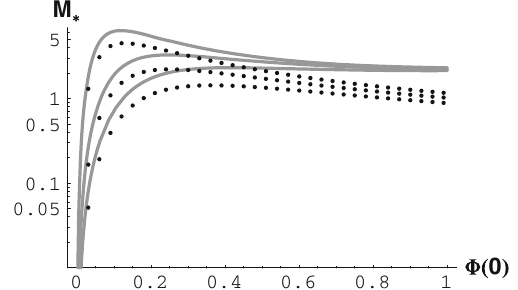
Fig. 7 Charged boson star mass (approximated using the second-order √ (cid:14)/( Gm ) as a function of (cid:15)( 0 ) = functions) in units of g = 0 . 1 , 0 . 2 , and 0 . 3 (from the upper line to the lower line) for the case (cid:14) → ∞ . The dots indicate the numerical